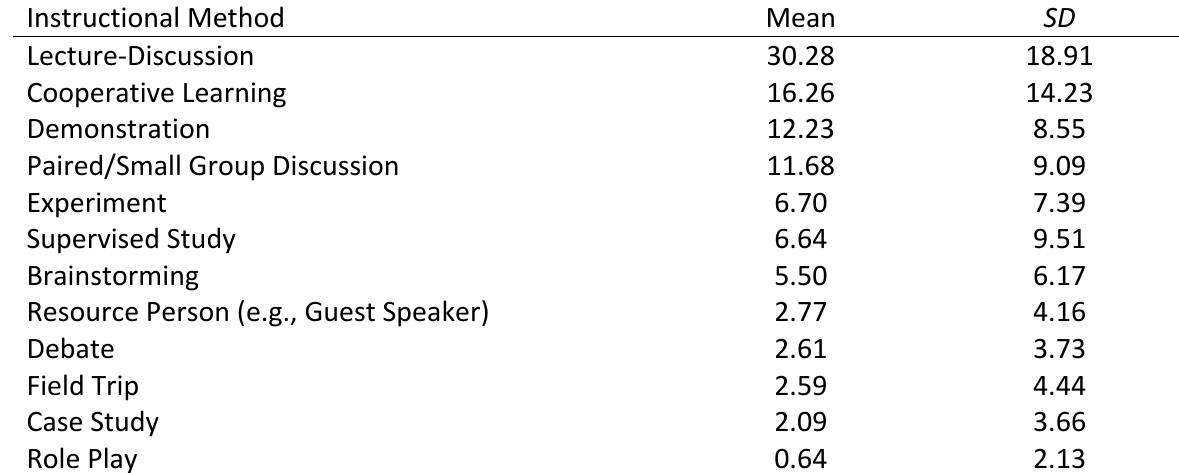
Teachers’ Perceived Use of Instructional Method by Percent Class